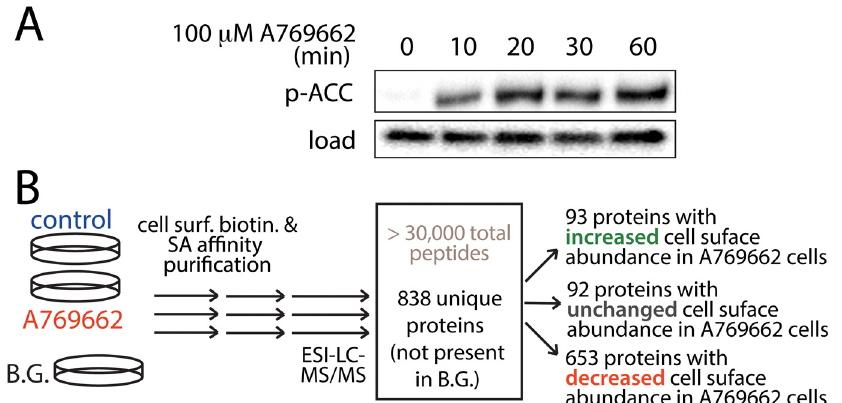
Fig 1. AMPK activation and mass spectrometry analysis of cell surface proteins. ( A ) RPE cells were stimulated with 100 μ M A-769662 in media containing 0.1% FBS for indicated times. Shown are representative immunoblots using antibodies as indicated. ( B ) Shown is a diagram depicting cell stimulation, surface biotinylation, purification of biotinylated proteins, mass spectrometry and peptide identification. We thus identified a total of 838 proteins within all cell surface fractions, of which 653 exhibited reduced detection in the cell surface fraction of cells treated with A-769662, 93 proteins exhibited increased cell surface abundance in cells treated with A-769662, and a further 92 were classified as exhibiting largely unaltered detection in the cell surface fraction upon AMPK activation. A complete list of identified proteins can be found in S1